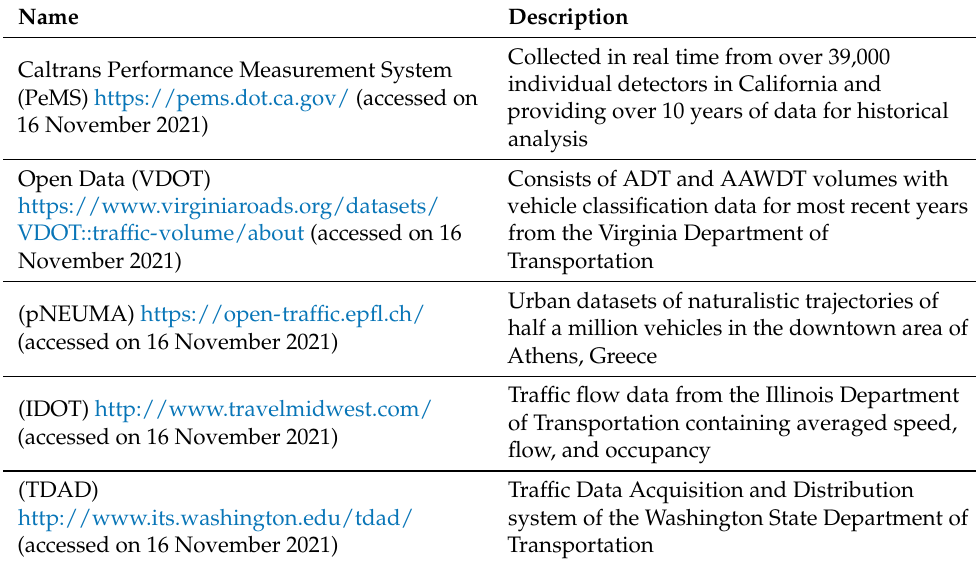
Table 28. List of the publicly available datasets found during this